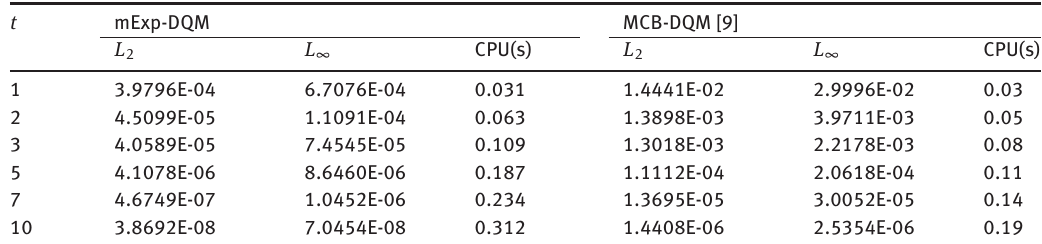
Table 4: Comparison of the mExp-DQM solutions of Example 5.2 with h = 0.1, (cid:2) = 0.01, α = 1, β = 1, p = 1